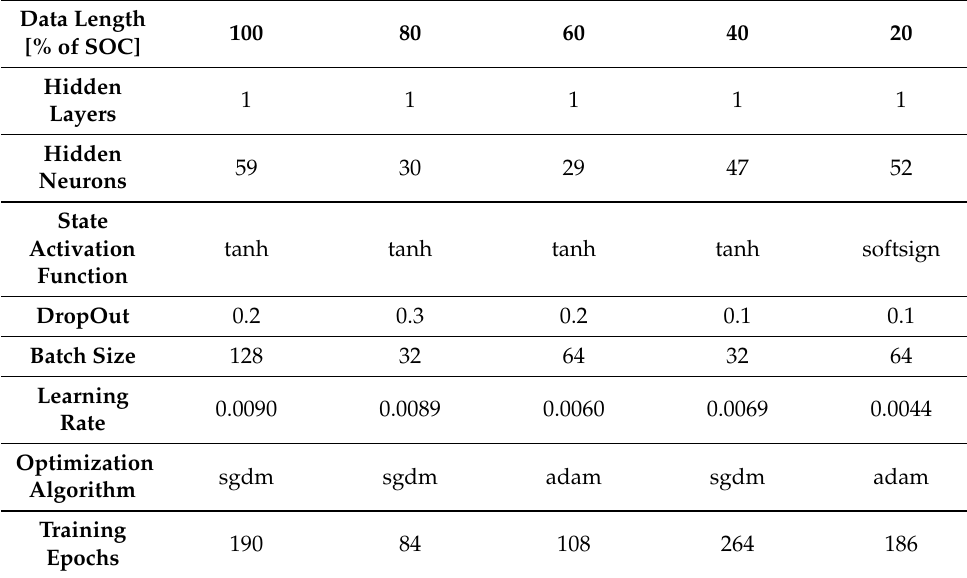
Table 4. Analysis #1: Best neural network training and architecture